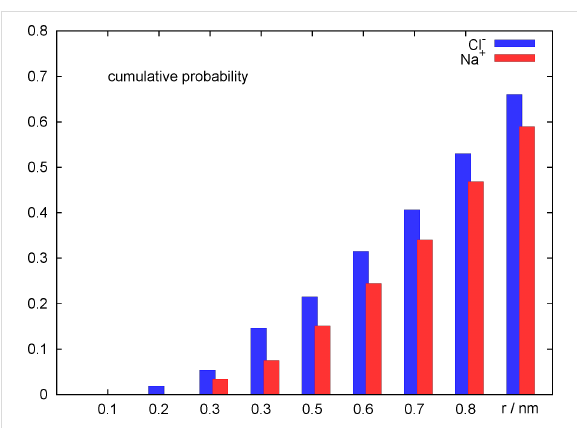
Figure 6: Cumulative probability to observe proton discharge within a radius r around the Na + ion (red) and the Cl − ion in the system with only one adsorbed Cl − ion